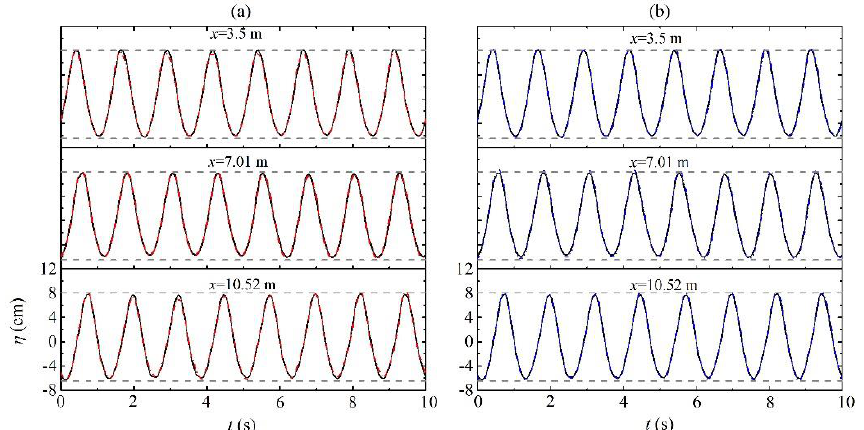
Figure 3. Comparisons of the surface elevations measured upstream of the interaction region for Case A2. ( a ) Wave elevations from the in-line probes in the A flume; ( b ) Wave elevations from two channels but in the same position in the local coordinate system.